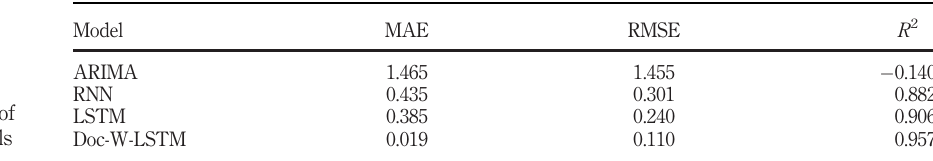
Table 7. Testing result of different